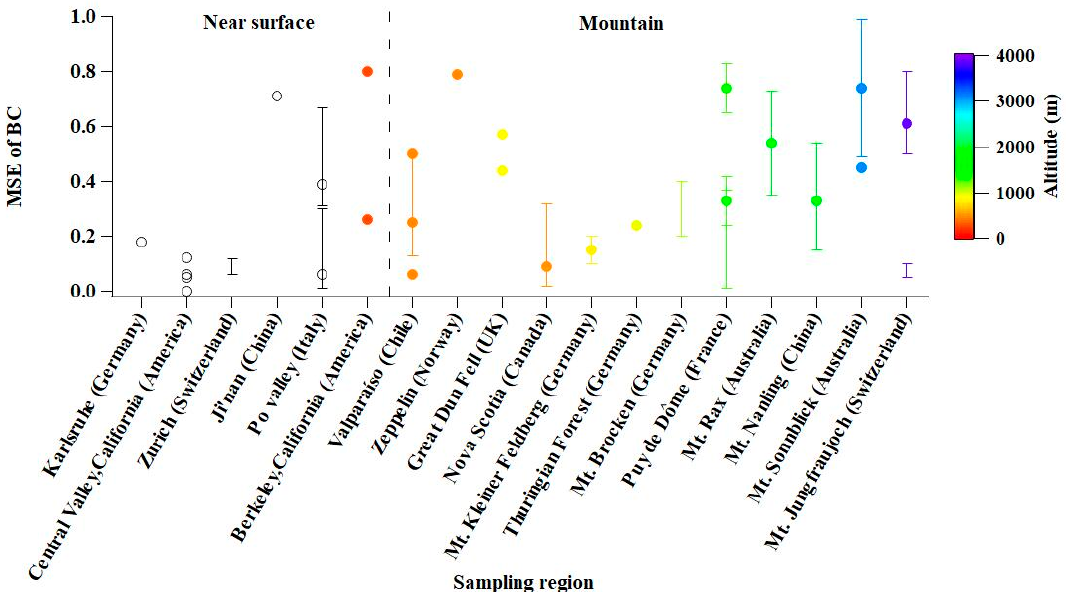
Figure 2. In-cloud mass scavenging efficiency (MSE) of BC (mean or median values with observed ranges) reported in previous literatures, separated for near ground surface and mountain sites. The color scale denotes the altitudes of the sampling sites while the hollow dots denotes no altitude data available. More than one dot for a single site means the SEs were measured under different circumstances (e.g., time [78,79], diameter ranges [37], cloud types [35], air masses [38,83], peak supersaturation [84], etc.). Observational data were collected from Karlsruhe, Germany [85], Central